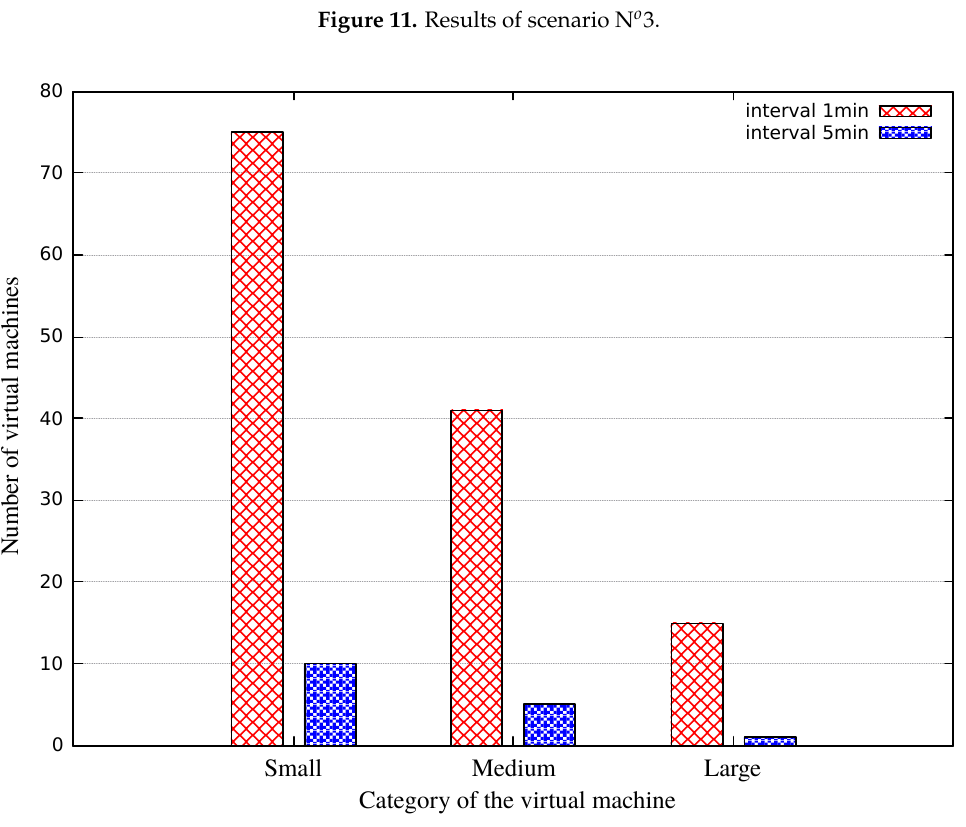
Figure 12. Number of virtual machines in scenario N o